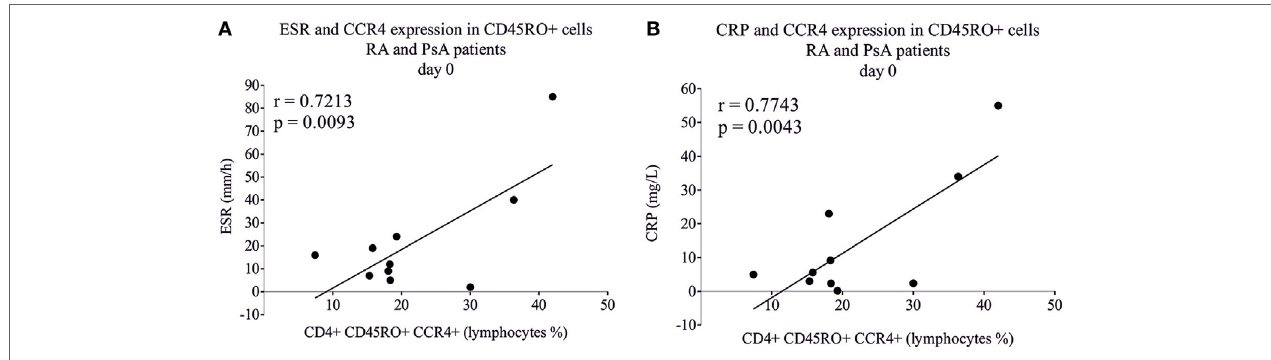
FigUre 6 | Correlation of inflammatory markers with chemokine receptor expression. CD4 + CD45RO + memory T cells were isolated by using magnetic separation and the CCR4 expression was measured by flow cytometry. Rheumatoid arthritis (RA) ( n = 5) and psoriatic arthritis (PsA) patients’ ( n = 5) samples were analyzed and correlated (Pearson correlation) to erythrocyte sedimentation rate (ESR) (a) and to C-reactive protein (CRP) (B)